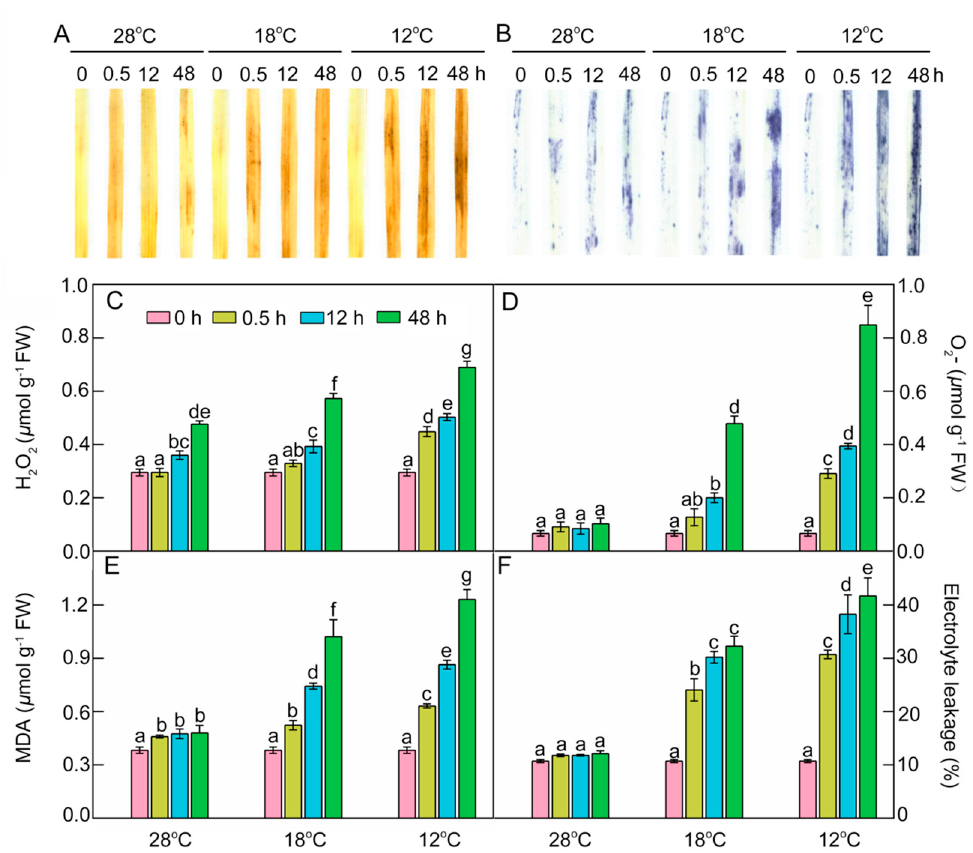
Figure 9. Effects of chill-stressed (18 °C and 12 °C) on H 2 O 2 ( A , C ), O 2. − ( B , D ), MDA content ( E ), and EL ( F ) of rice seedlings. Histochemical detection ( A , B ), content of H 2 O 2 ( C ), O 2. − ( D ), MDA ( E ), and EL ( F ) of control (28 °C) and chill-stressed (18 °C and 12 °C) rice seedlings after 0 h, 0.5 h, 12 h, and 48 h greening. Six day old etiolated seedlings were treated with 18 °C or 12 °C chilling stress. Seedlings were harvested at 0 h, 0.5 h, 12 h, and 48 h of greening and their ROS levels were measured. Values are means ± SD from three independent biological replicates. Different letters indicate significant differences according to Duncan’s multiple range tests ( p < 0.05 ).